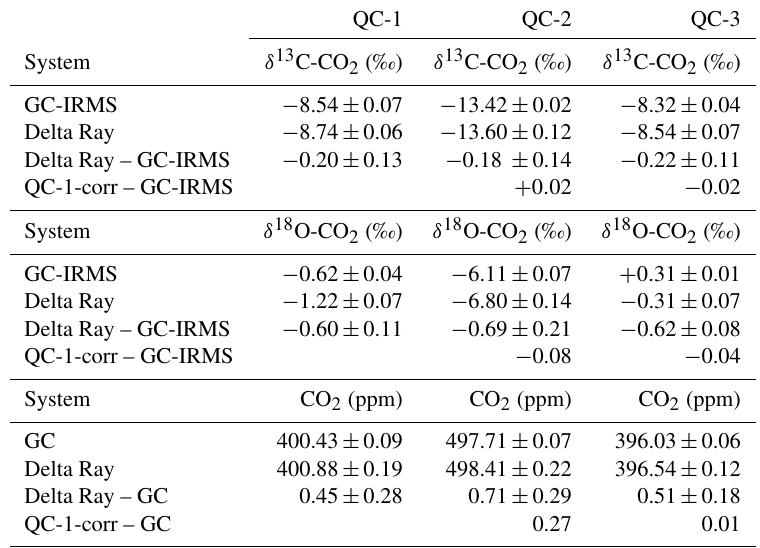
Table 3. Target values (GC and GC-IRMS) and Delta Ray measurements for QC-1, QC-2 and QC-3 as determined during operation at BHD and differences as Delta Ray minus GC-IRMS and values for QC-2 after correction for the offset in QC-1 minus the GC-IRMS target value. QC-1 QC-2